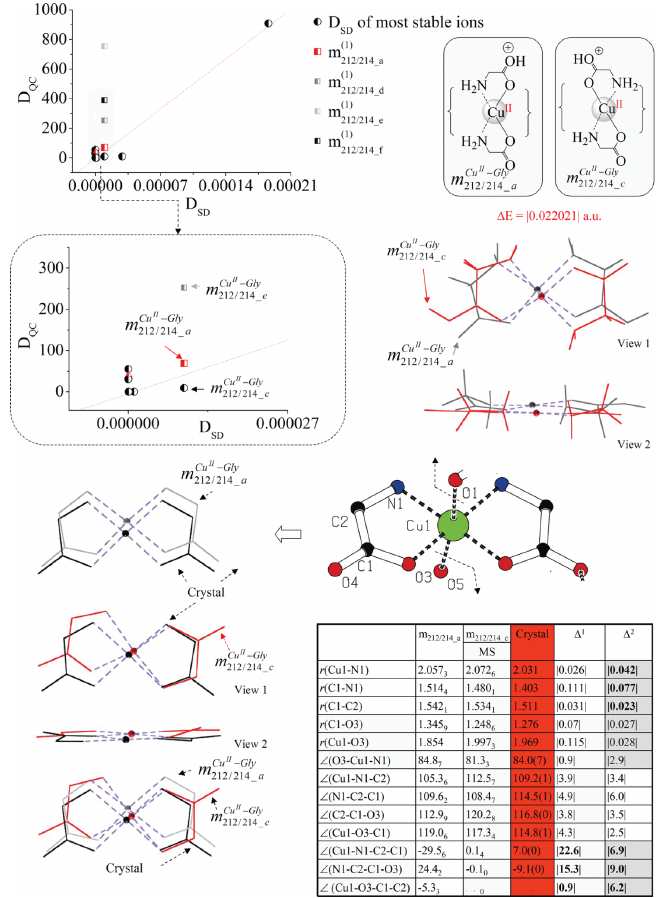
Figure 2: Relation between the D and D parameters [cm 2 ·s − 1 ] of MS ions of the complex {[Cu II (Gly) SD QC based on equation (1) and the Arrenius ’ s approximation to D parameter; crystallographic and mass spectrometrically QC determined 3D molecular structures of the complex together with the energetics ( Δ E [a.u.]) of most stable molecular con- formations labeled as m and m ; selected geometry parameters, for instance, bond lengths [Å], torsion and 212/214_a 212/214_c dihedral angles (°),